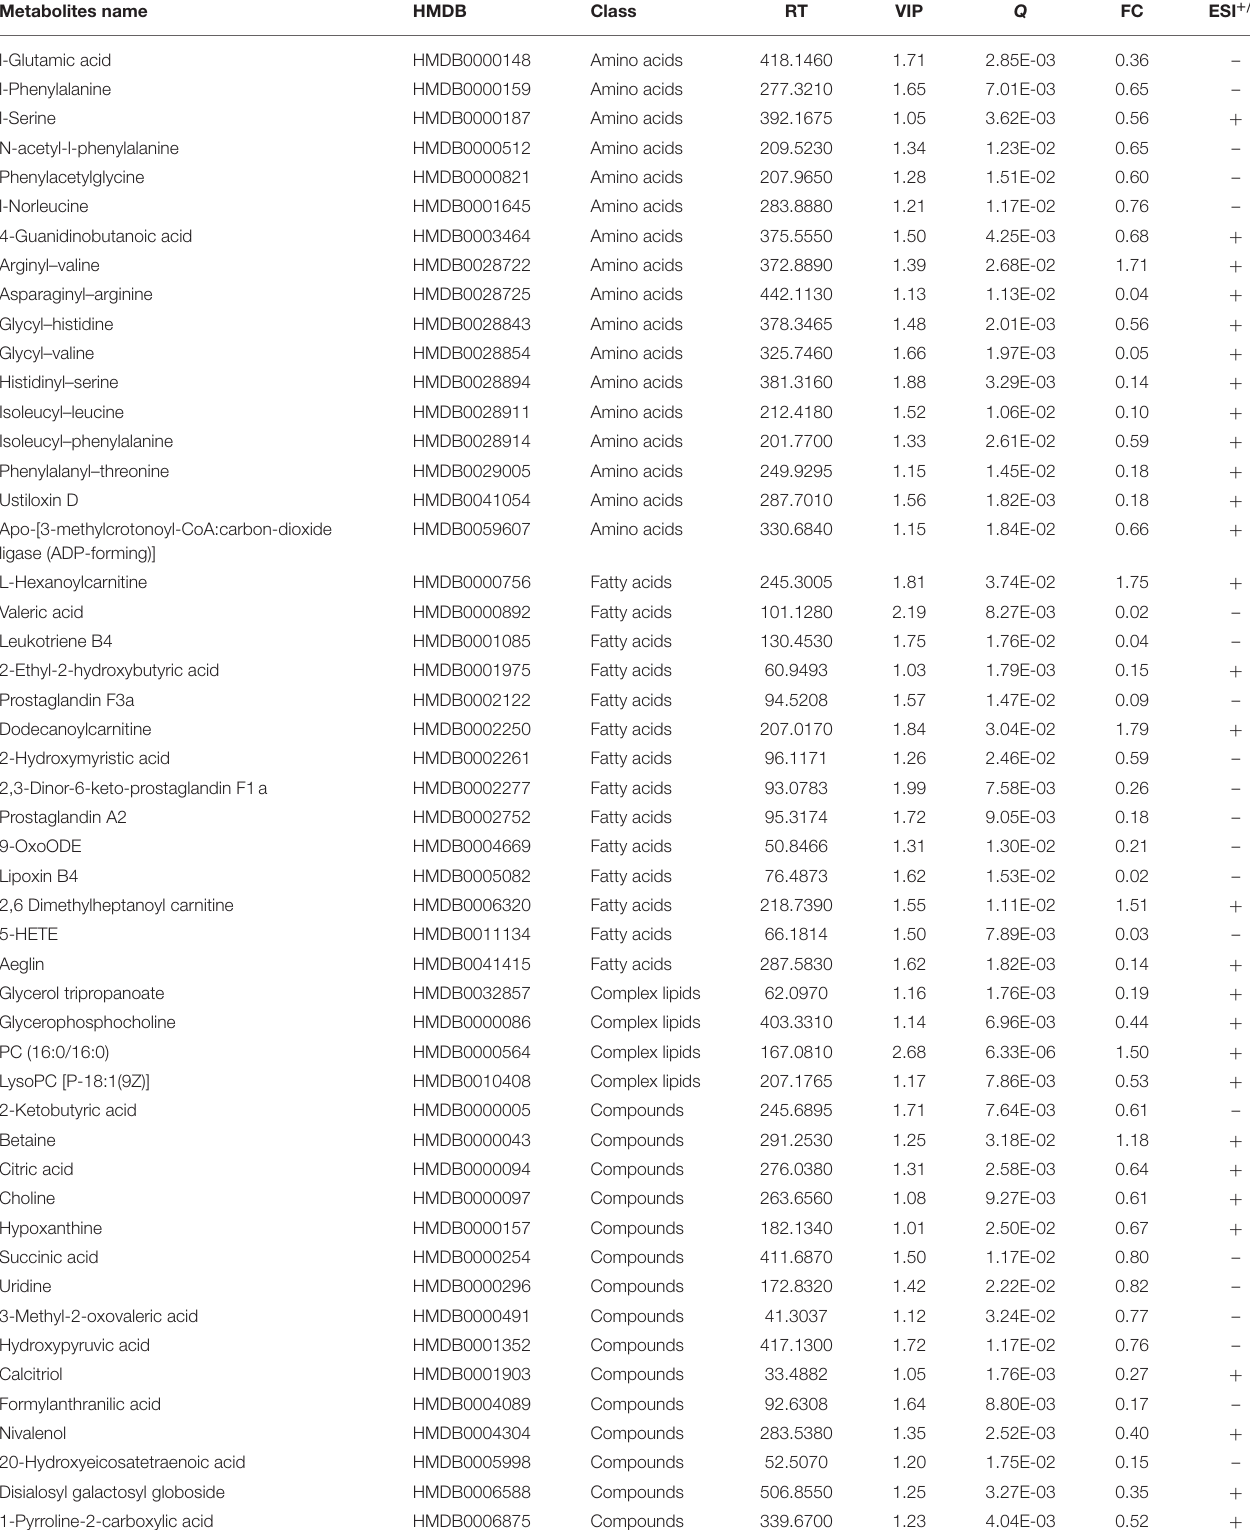
TABLE 2 | Differential metabolites in the serum between the antenatal depression (AD) and antenatal depression (NAD)